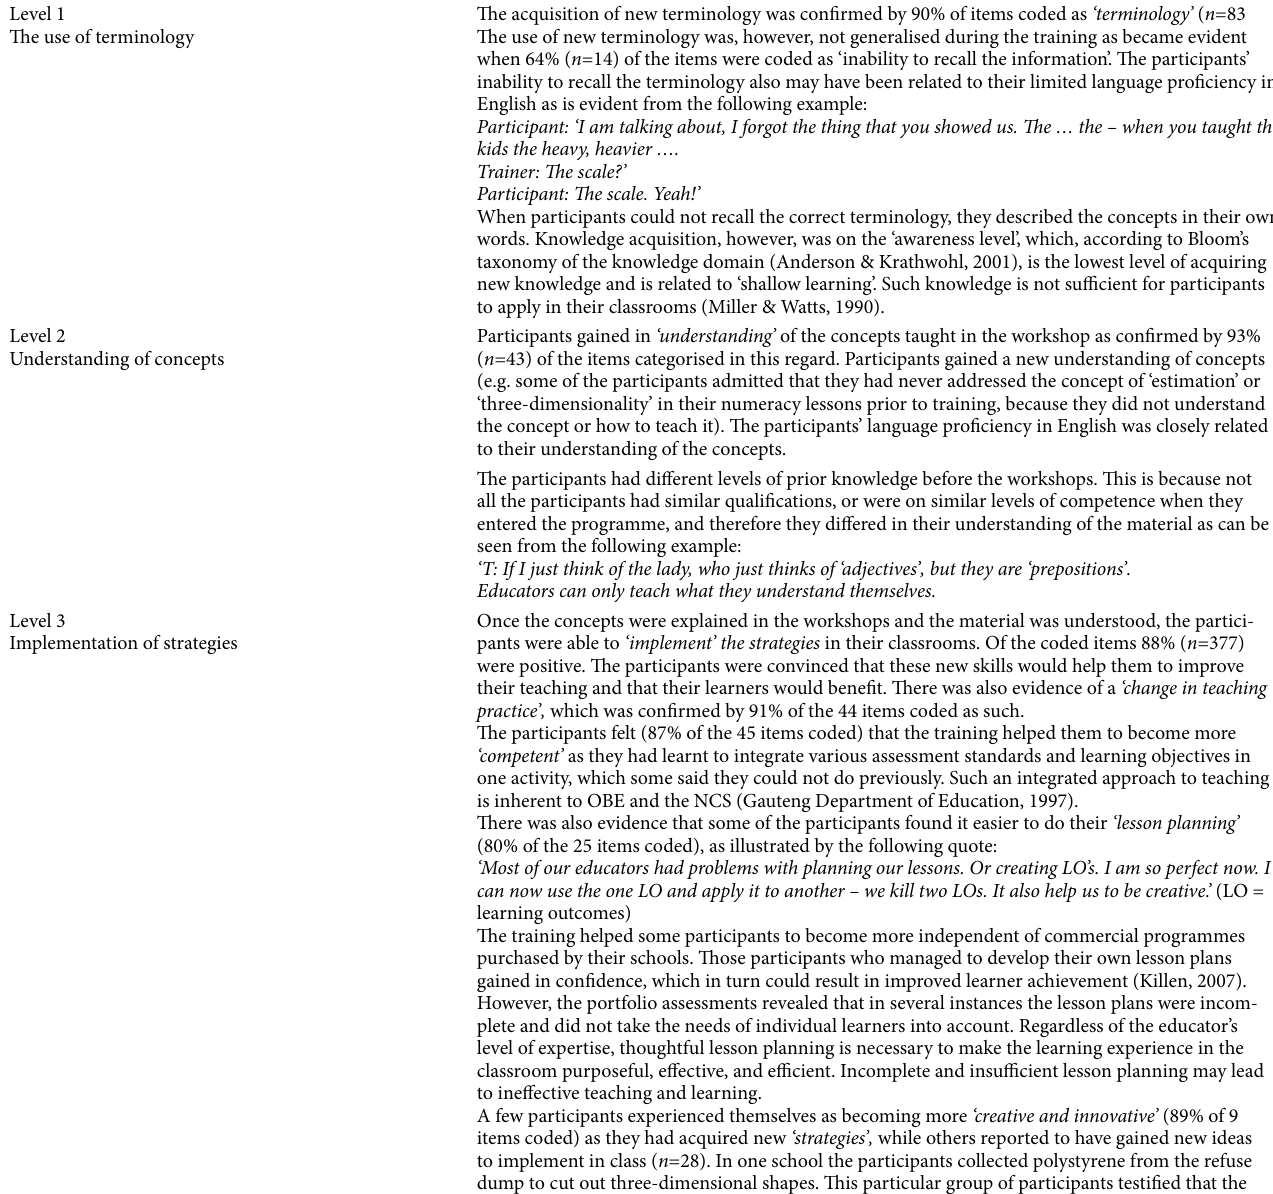
table I. Qualitative inferences re gains made in knowledge and skills by the participants Level of knowledge and skills